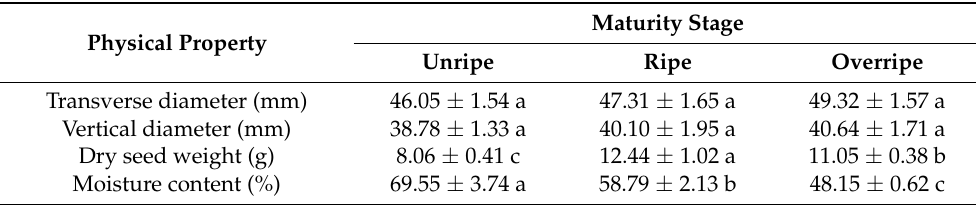
Table 2. Physical properties of Camellia oleifera with different maturity stages.